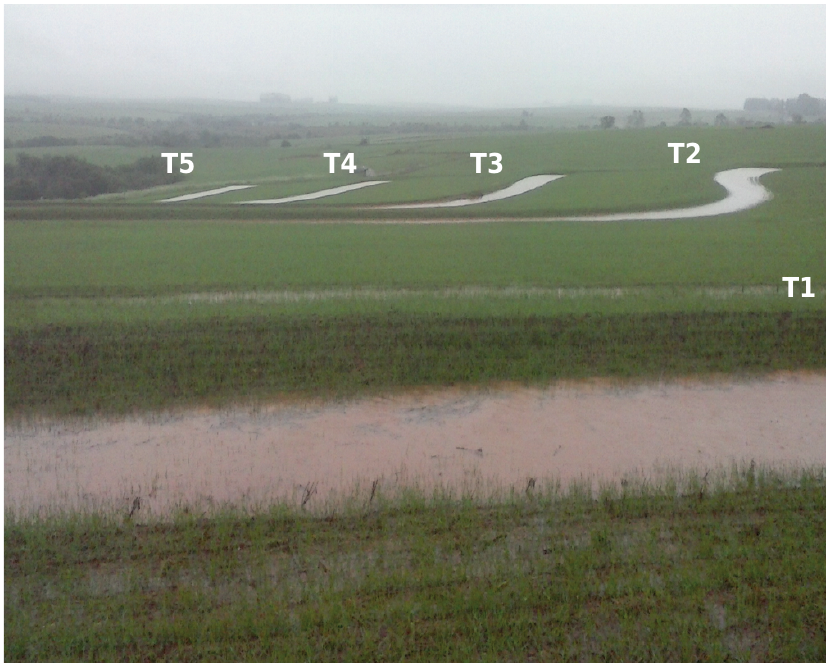
Figure 1. Terraced catchment and effect of the terraces in controlling runoff after a stormwater event (07/20/2015) with rainfall volume of 65 mm and maximum 30-min intensity of 18 mm h -1